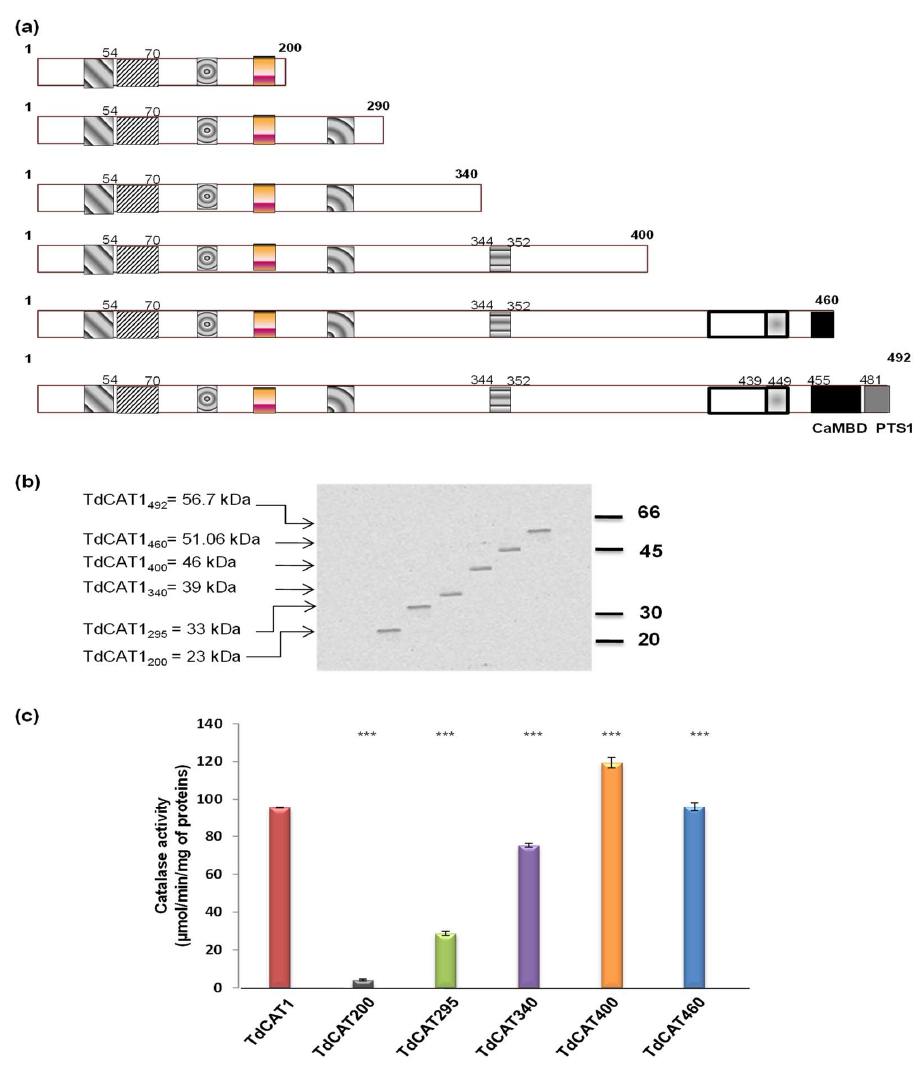
Figure 3. TdCAT1 harbors a putative autoinhibitory domain in its C-terminal portion. ( a ) Schematic representation of different deleted forms used in analyzing catalase activity of TdCAT1. ( b )